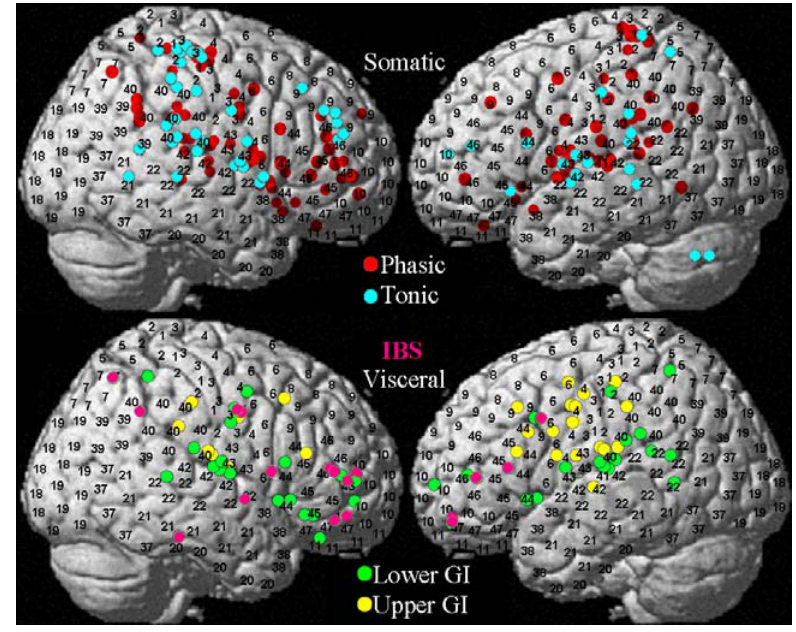
FIGURE 6. The center of each reported rCBF increase as for Fig. 5 but plotted onto the right and left lateral surface.